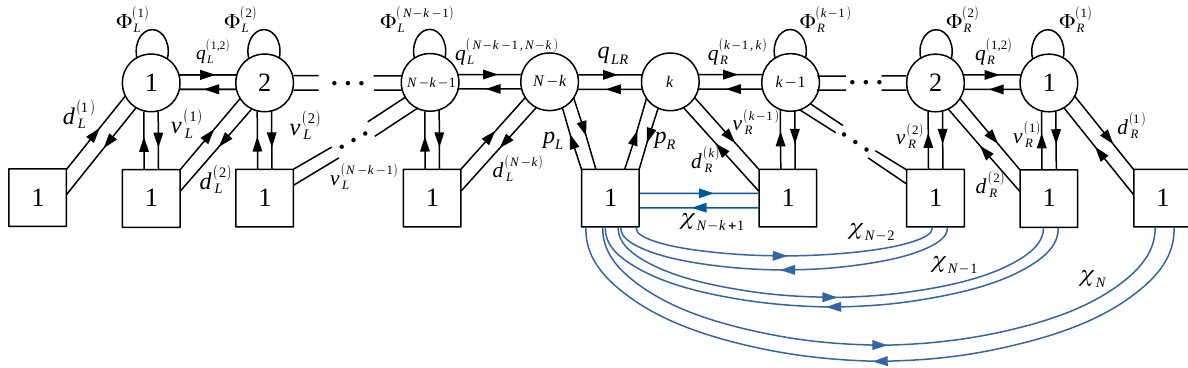
Figure 4 . Recombination dual frame of G [U( N